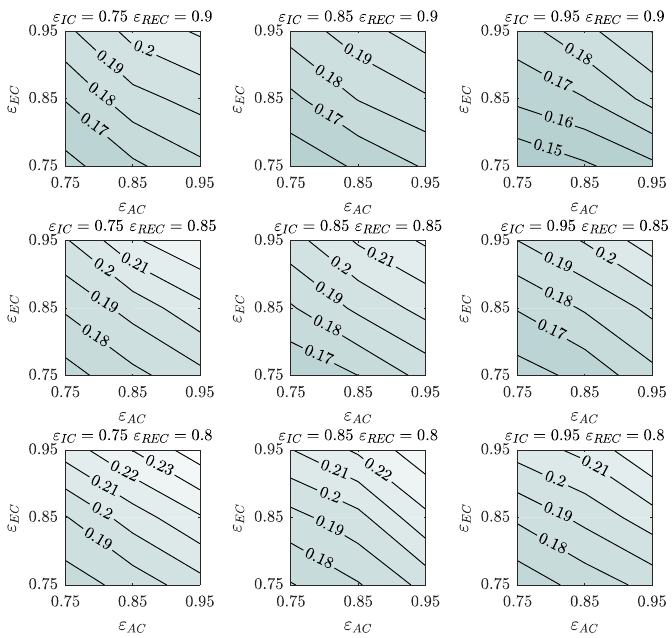
Figure 4. Absolute humidity at the inlet of the combustion chamber across the design space